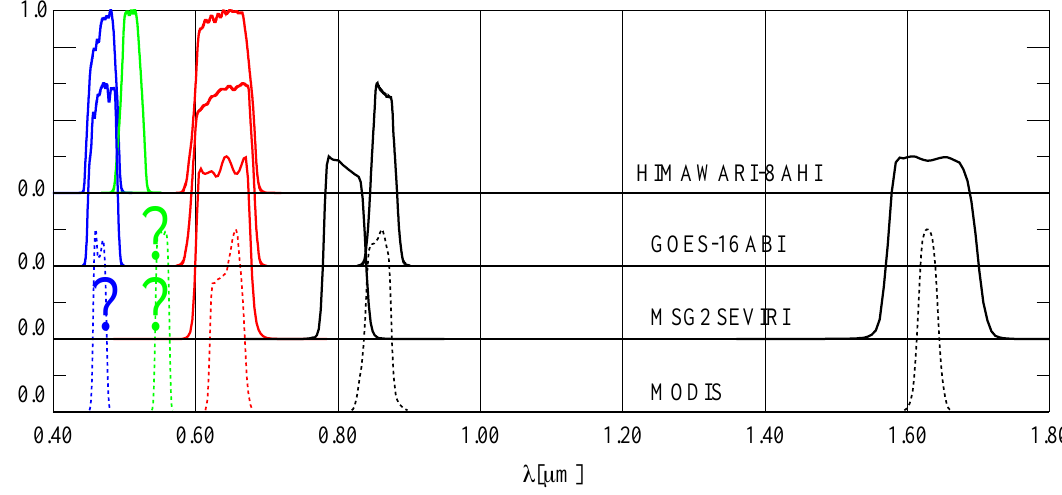
Figure 2. Normalized spectral response functions of Himawari-8 AHI, GOES-16 ABI, MSG2 SEVIRI (solid lines), and MODIS (dotted lines) visible and near-infrared (VNIR) bands, shifted along the y -axis for the sake of clarity. The questions marks indicate the missing visible bands in GOES-16 ABI and MSG2 SEVIRI